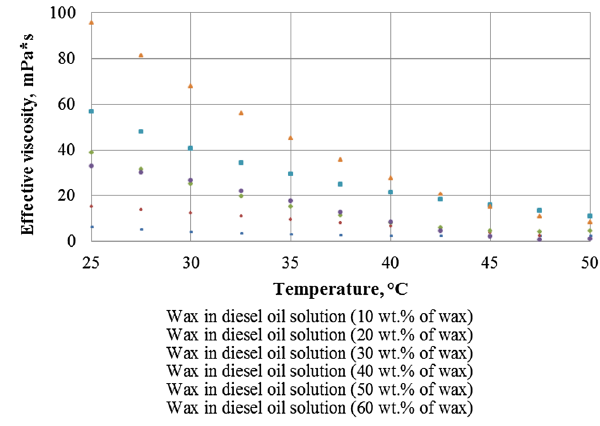
Fig. 3 Effect of wax and impurities concentration on WAT in the wax-bearing solutions by visual method Fig. 4 Effect of temperature on viscosity of the wax-bearing